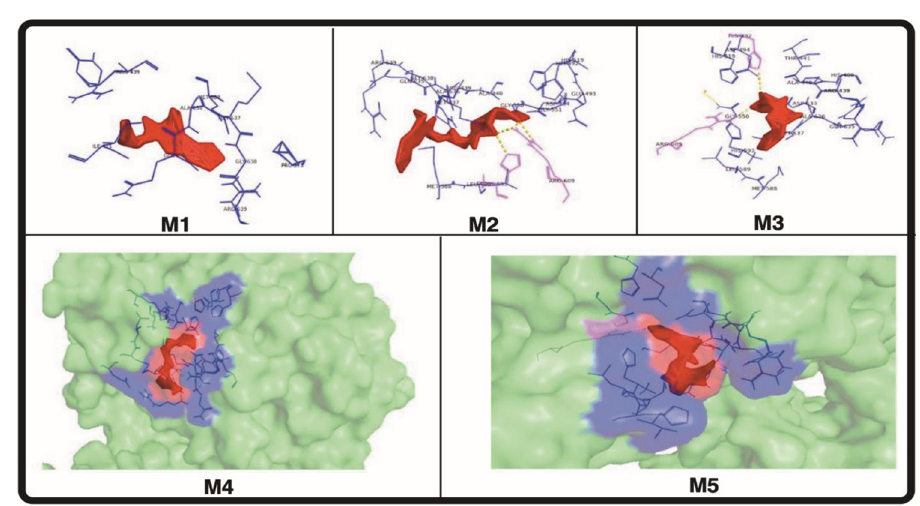
Fig 3. In-silico molecular docking of ligands with urease (4H9M).